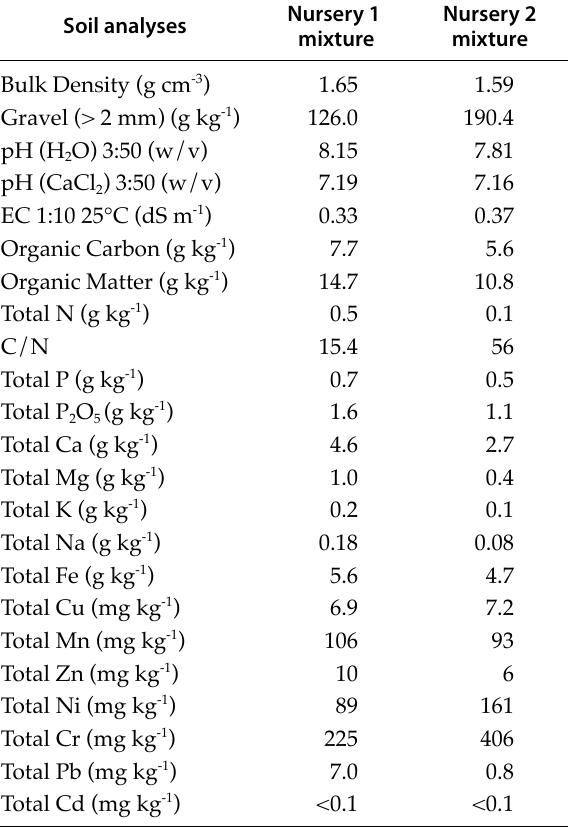
Table 1. Chemical and physical analyses of the nursery growing mixture from two citrus